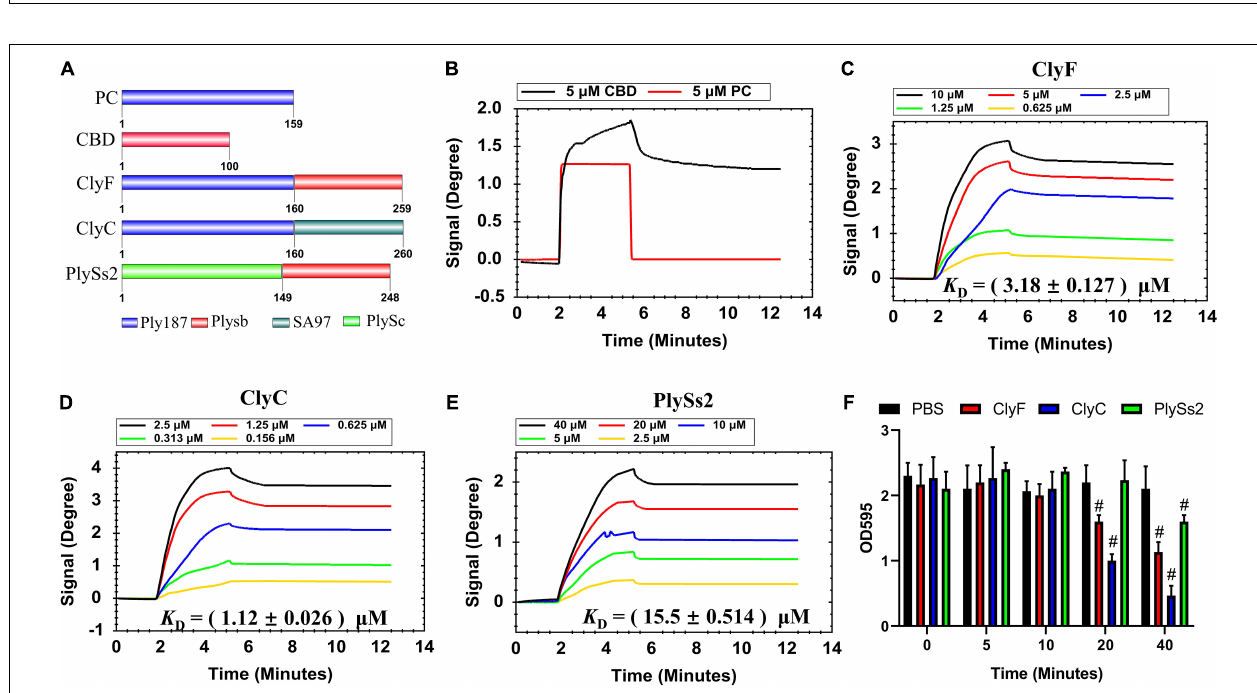
FIGURE 3 | SPR sensorgrams and resulting affinity fit curves for ClyF binding to cultured-on-chip S. aureus biofilm analyzed by two binding models responding to 1:1 and 1:2. (A,B) Sensorgrams of the binding curves (colored lines) and the fitted data (black lines). (C,D) Corresponding plots (blue dots) and fitted data (black lines) of steady-state binding from the end of the association phases against two-fold serially diluted concentrations.